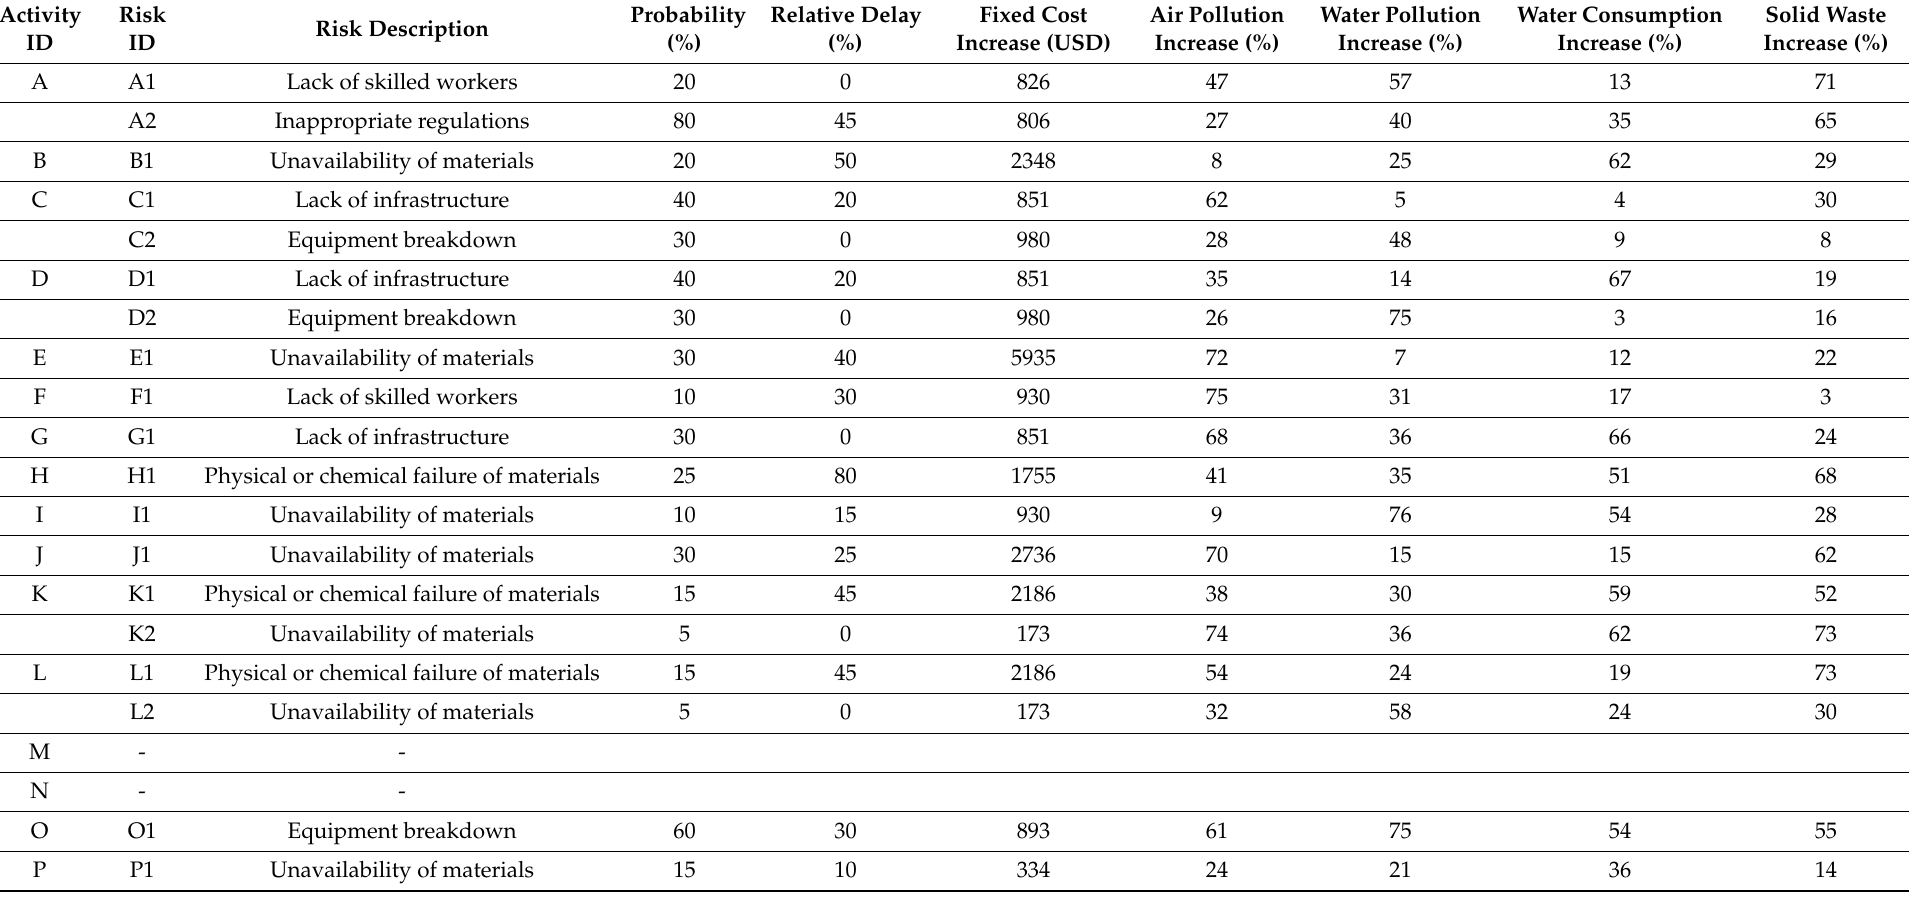
Table 3. List and Impacts of Risk